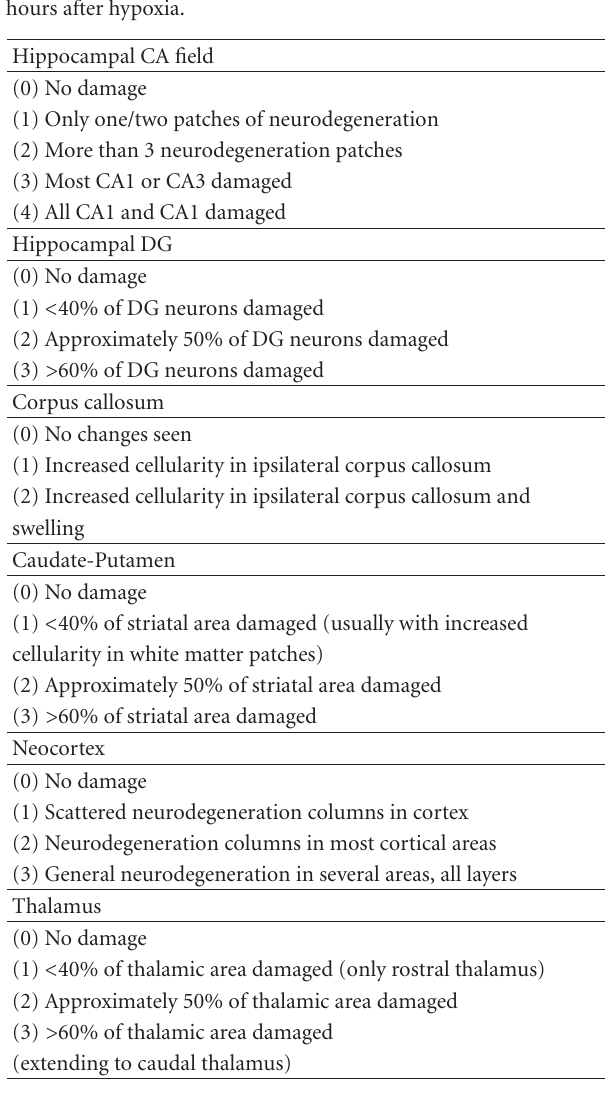
Table 1: Injury score grading system. Survival times from 3 to 72 hours after hypoxia.